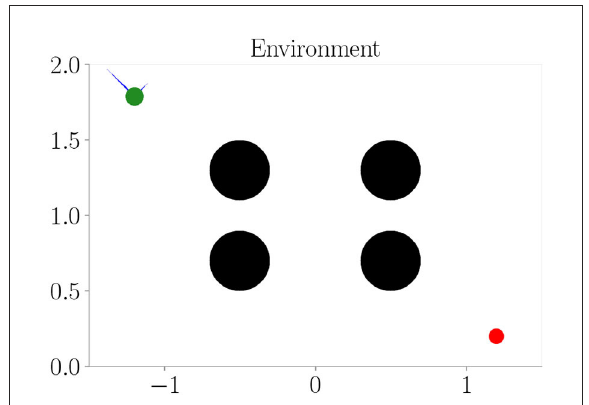
FIGURE3 The simulation environment we use in our experiments. It resembles a confined space in which a vehicle (green) can move around by adjusting its throttles (blue). Its goal is to navigate toward the target (red). Depending on the experiment, obstacles or different terrains (black) are present, which affect the vehicle’s sensorimotor